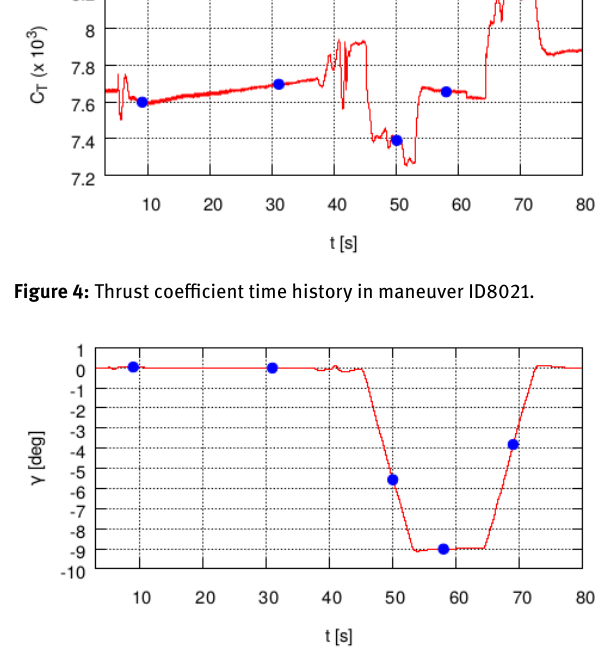
Figure 6: Collective and cyclic control time histories in maneuver